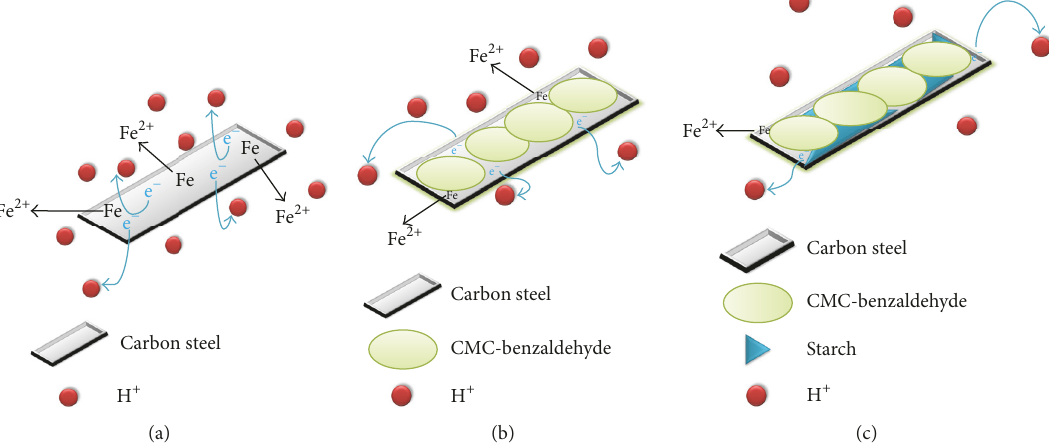
Figure 8: Hypothesis of corrosion mechanisms for the following: (a) without the addition of CMC-benzaldehyde inhibitors, (b) with the addition of CMC-benzaldehyde inhibitors, and (c) with the addition of CMC-benzaldehyde and starch inhibitors.